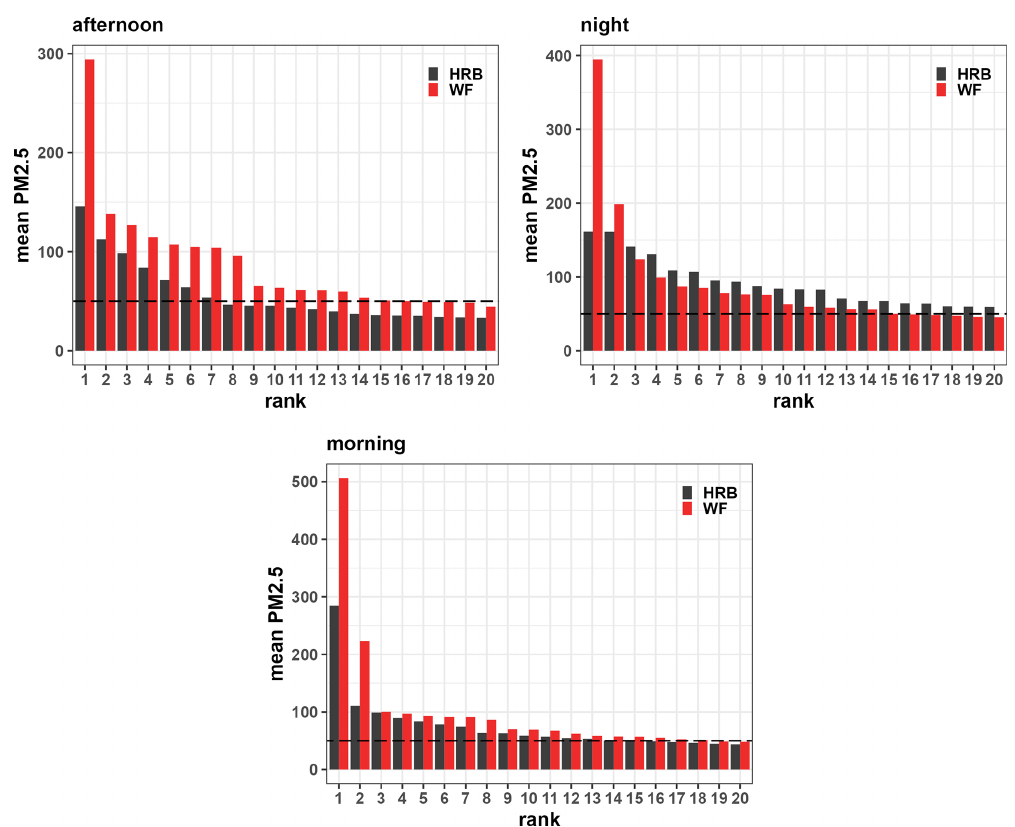
Figure 4. Highest mean PM 2 . 5 values for each 6h time period for HRBs and WFs. For each date, only the single top value from all AQS values is shown (i.e. the second highest for each date is not shown). The dashed line indicates 50µgm − 3 for reference between the three plots. Note that our data only include situations with one fire within 150km of an AQS for a particular date.